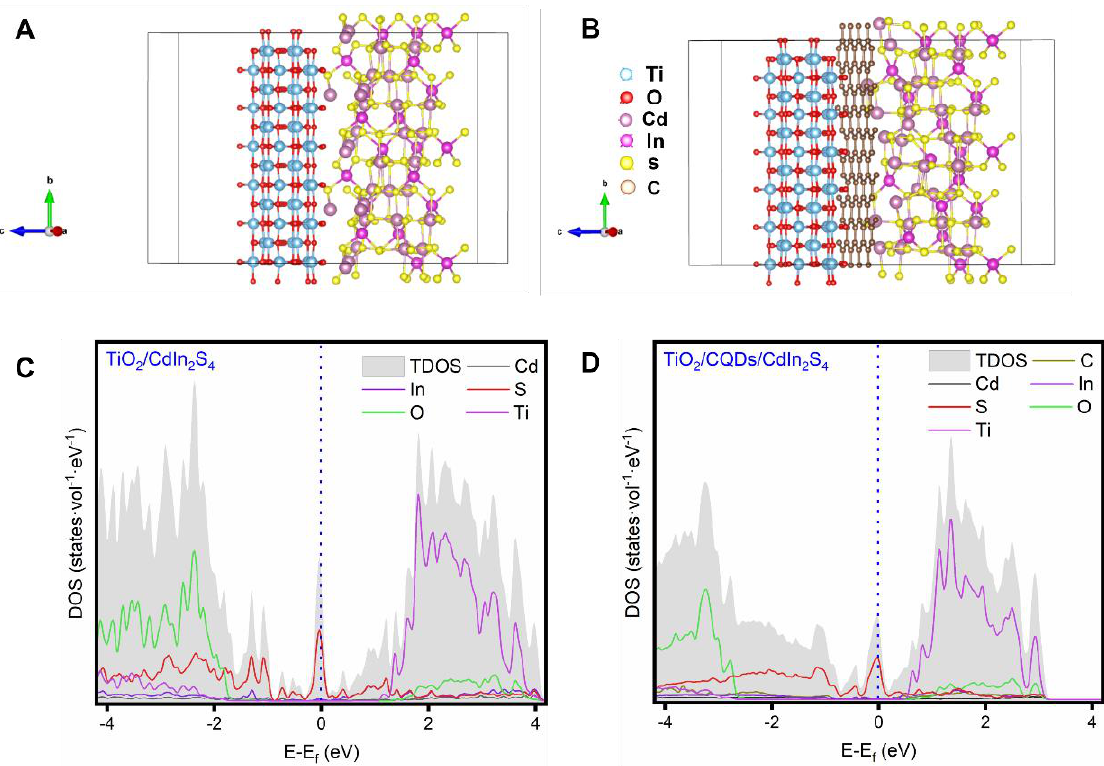
Figure 3. The crystal structures of ( A ) TiO 2 /CdIn 2 S 4 and ( B ) TiO 2 /CQDs/CdIn 2 S 4 ; density of states of ( C ) TiO 2 /CdIn 2 S 4 and (D) TiO 2 /CQDs/CdIn 2 S 4 .